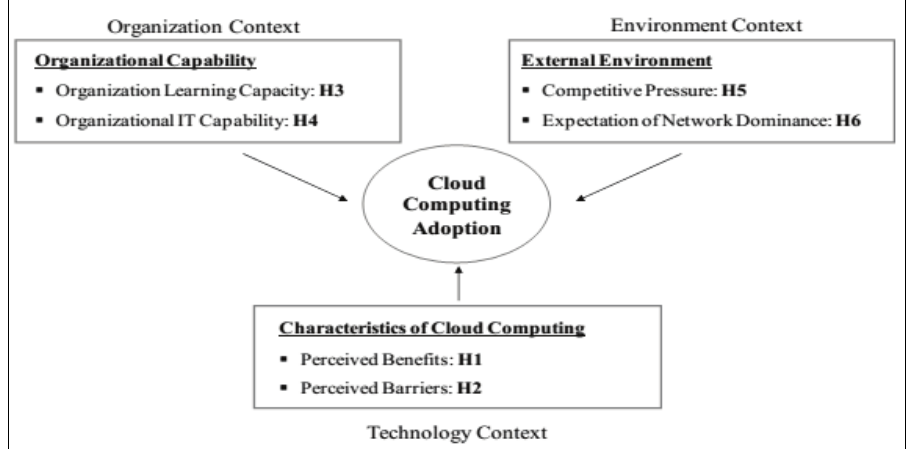
Fig.5. Cloud Computing Adoption Model (source: 28, see